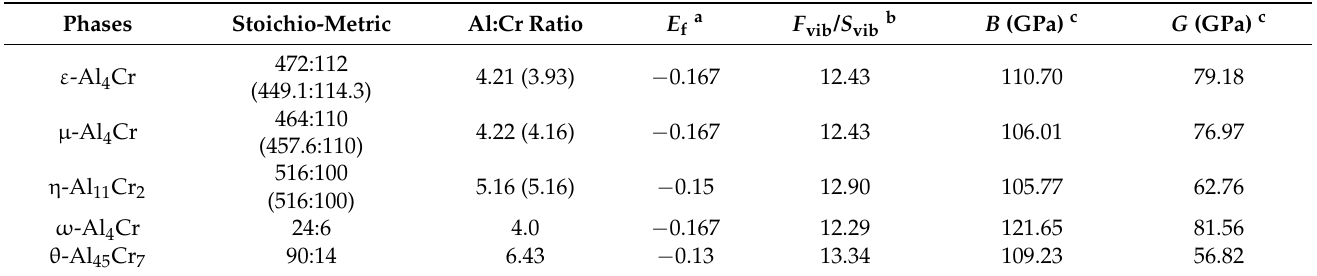
Table 1. Formation Energy (eV/atom), vibrational free energy and entropy, bulk modulus and shear modulus of related phases in the Al-Cr system by the deep neural network